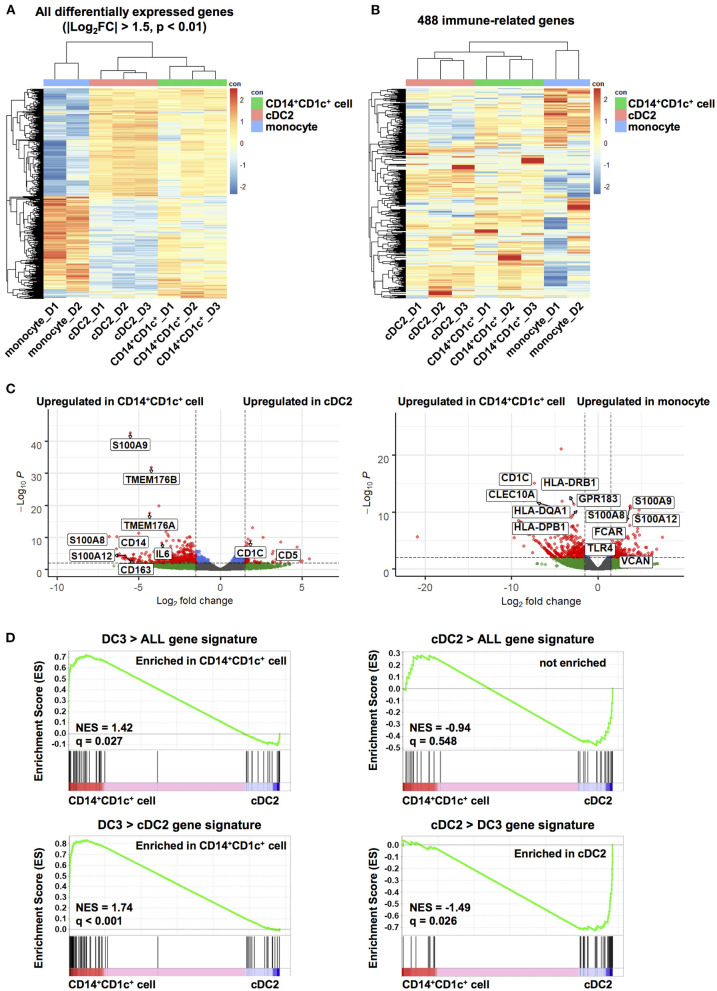
Transcriptome analysis of human dendritic cell populations in hNOJ mice. Total RNA was extracted from CD14+CD1c+ cells, cDC2s, and monocytes isolated from the spleen of IVT-hNOJ mice and sequenced. (A) Heatmap visualization of the z-scores for the all DEGs among CD14+CD1c+ cells (n = 3), cDC2s (n = 3), and monocytes (n = 2) obtained (|Log2FC| > 1.5, p-value < 0.01) using the hierarchical clustering analysis. (B) Heatmap visualization of the z-scores for 488 genes expressed in at least one sample among CD14+CD1c+ cells (n = 3), cDC2s (n = 3), and monocytes (n = 2) obtained using the hierarchical clustering analysis using with the sets of genes corresponding to Gene Ontology annotation “immune system process.” The colors in the heatmap indicate high (red) or low (blue) expression across the sample set. (C) Volcano plots displaying DEGs between two subsets in hNOJ mice (CD14+CD1c+ cells vs. cDC2s, CD14+CD1c+ cells vs. monocytes). Genes with |Log2(fold change)| > 1.5, and p-value < 0.01 were considered significant (red plot). (D) GSEA comparing CD14+CD1c+ cells and cDC2s derived from hNOJ mice using published cDC2s and DC3s gene signatures (29). Statistical significance was defined by normalized enrichment score (NES) and q-value calculated with GSEA software using the default parameter.